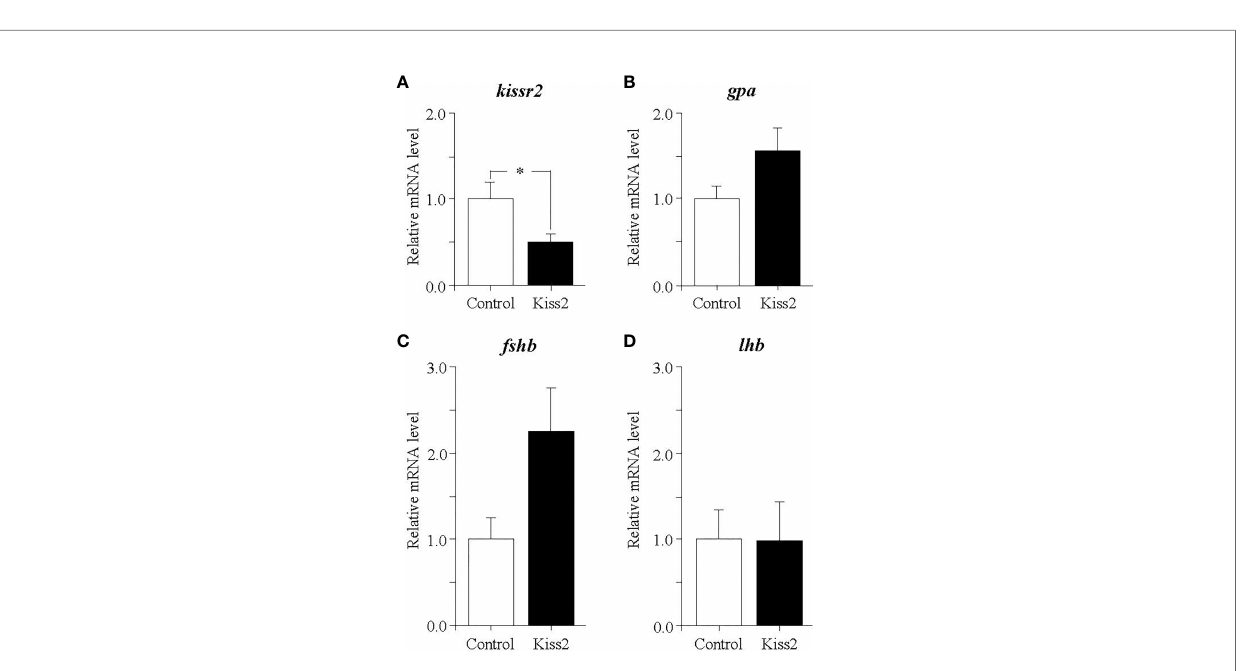
FIGURE 6 | Changes in the relative mRNA levels of kiss2 and kissr2 (A) , gnih and gnihr (B) , gnrh1 (C) , gnrh2 (D) and gnrh3 (E) in the brain of grass puffer at regressed stage after intraperitoneal injection of gpKiss2 for the period of 12hrs. Values are presented as mean ± SEM (n = 6 − 7). Asterisks denotes a signi fi cant difference between the control and gpKiss2 injected fi sh (**, p < 0.01).